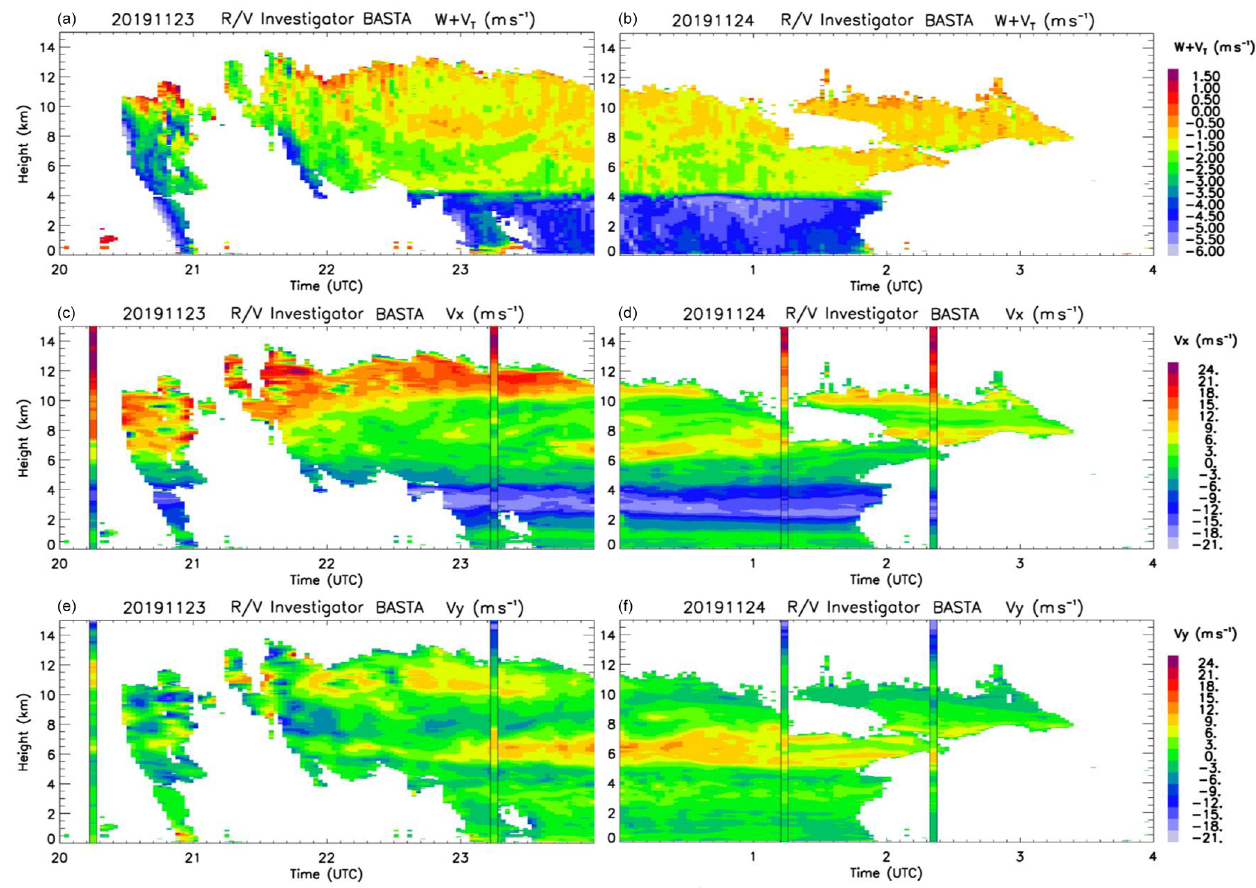
Figure 1. Time–height cross section of retrieved W + V T (a, b) , V X (c, d) , and V Y (e, f) in a stratiform precipitation case sampled on 23–24 November 2019 by the BASTA cloud radar on RV Investigator . Vertical lines on panels (c) and (d) and panels (e) and (f) are the horizontal wind components measured by the soundings. The reference time for the soundings is the launch time at